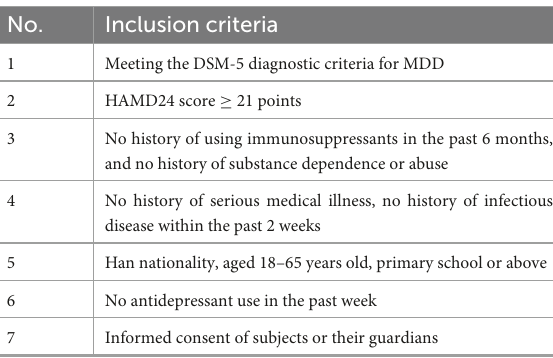
TABLE 1 Inclusion criteria for patients with depression.